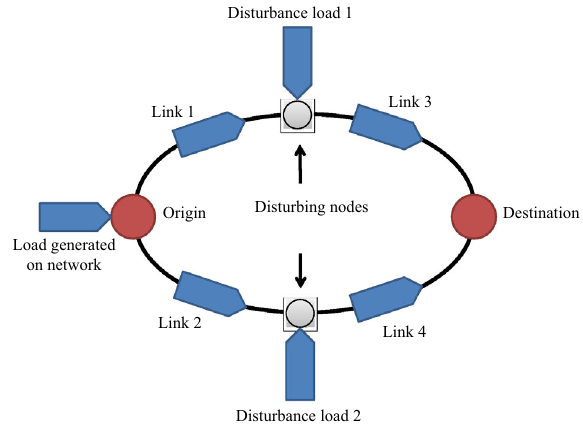
Fig. 7 Second scenario network scheme